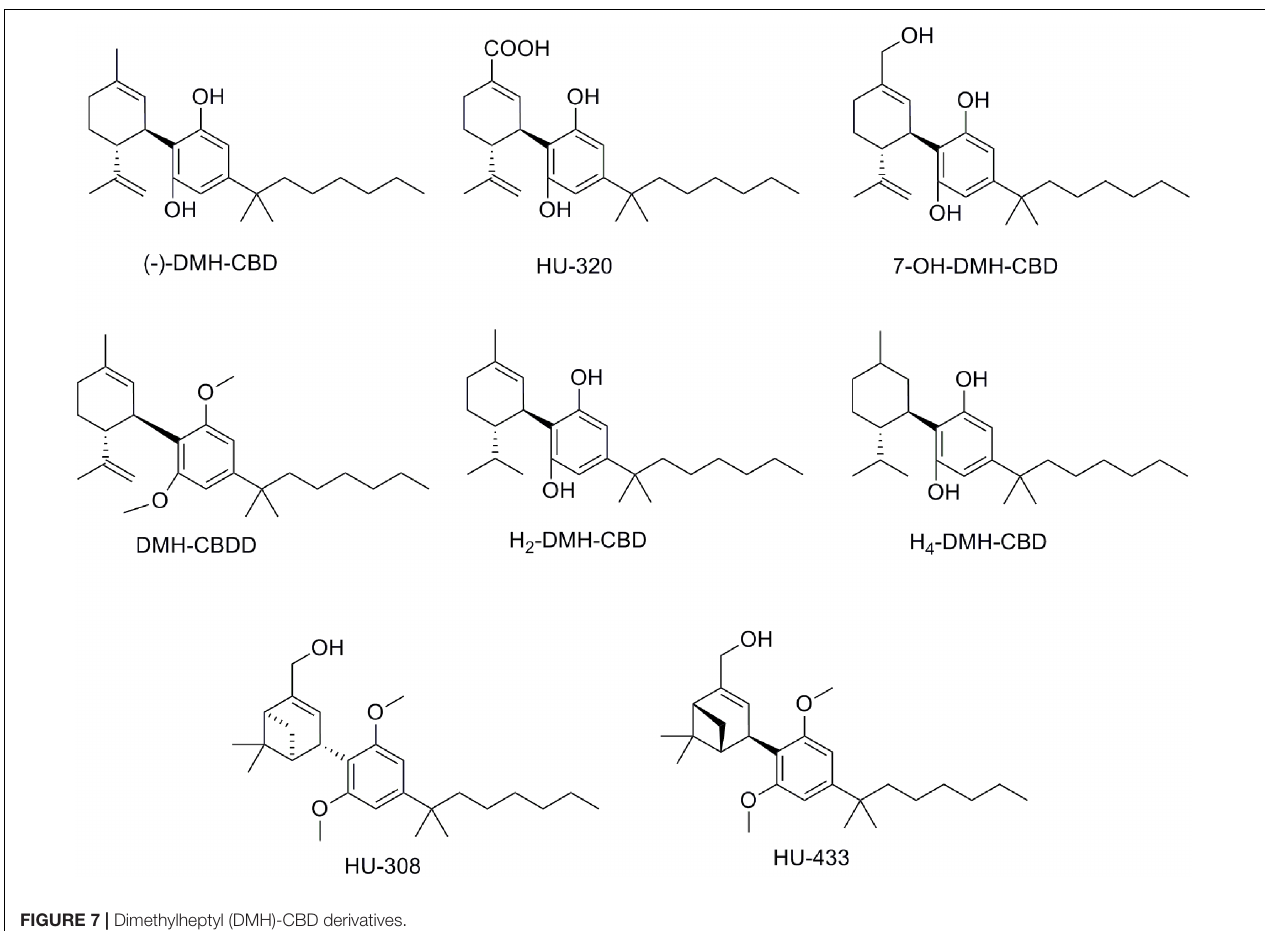
FIGURE 7 | Dimethylheptyl (DMH)-CBD derivatives.